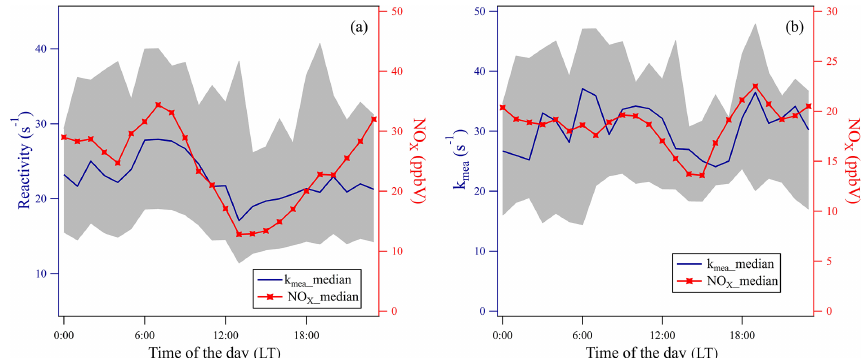
Figure 8. Diurnal variation of hourly median results of measured OH reactivity and NO x mixing ratios in Beijing (a) and Heshan (b)